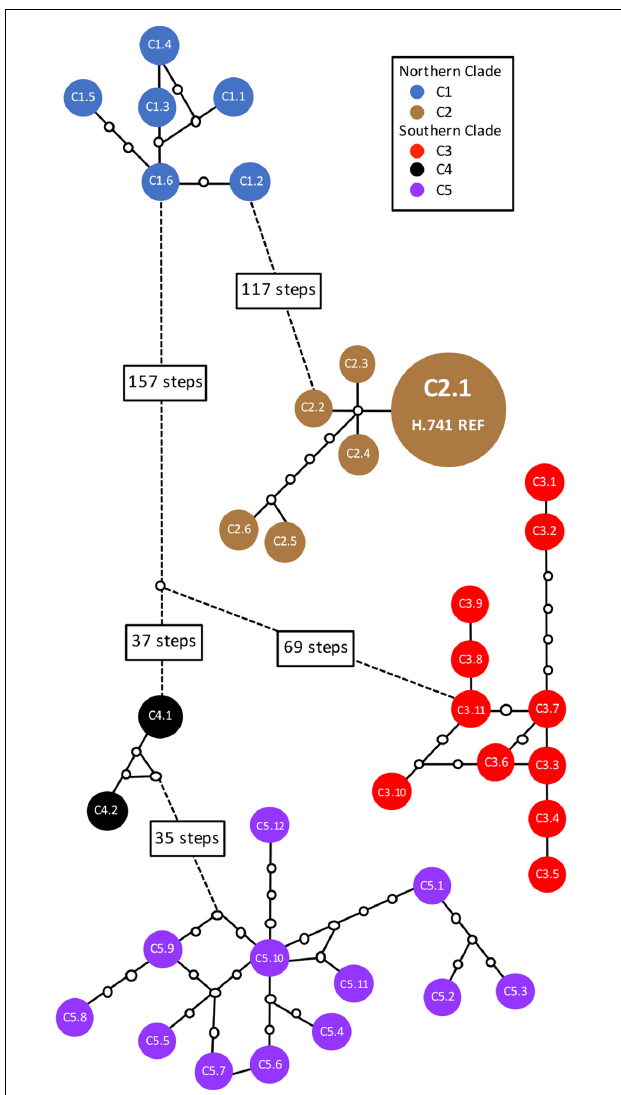
FIGURE 3 | Statistical parsimony network of 38 distinct chlorotypes from 63 wild and cultivated accessions of Macadamia integrifolia . Solid colored circles represent chlorotypes; connecting lines are mutational pathways between haplotypes; white circles are extinct or unsampled haplotypes; longer pathways are represented by dotted lines with text boxes showing the number of mutational steps. The chlorotype for each sample is listed in Table 1 . Chlorotype C2.1 of the reference genome (H.741 REF) was shared with three wild accessions (W04.MB1, W08.Mo3, W08.Mo4) and 18 other Hawaiian cultivated